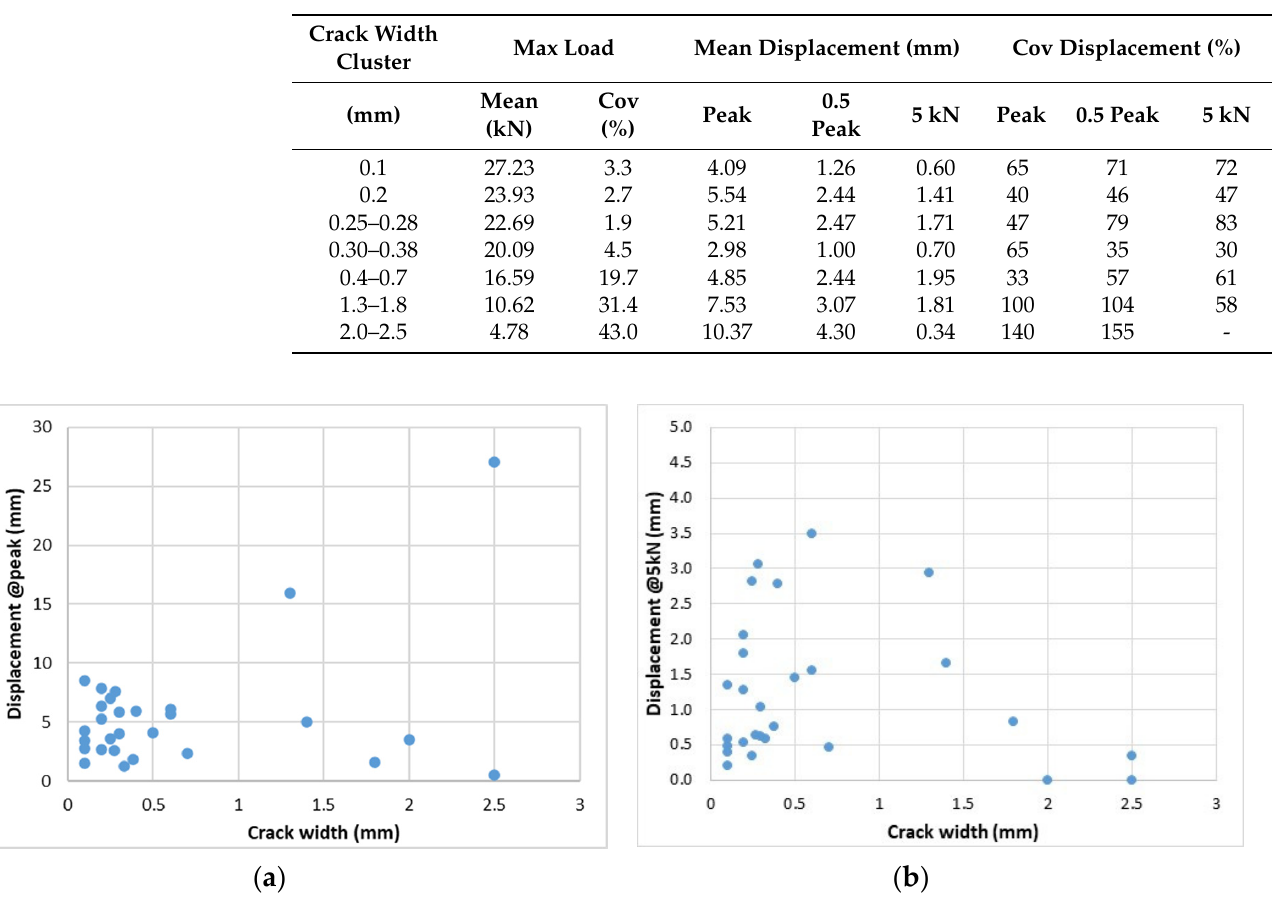
Table 3. Test results evaluated on the basis of crack width.